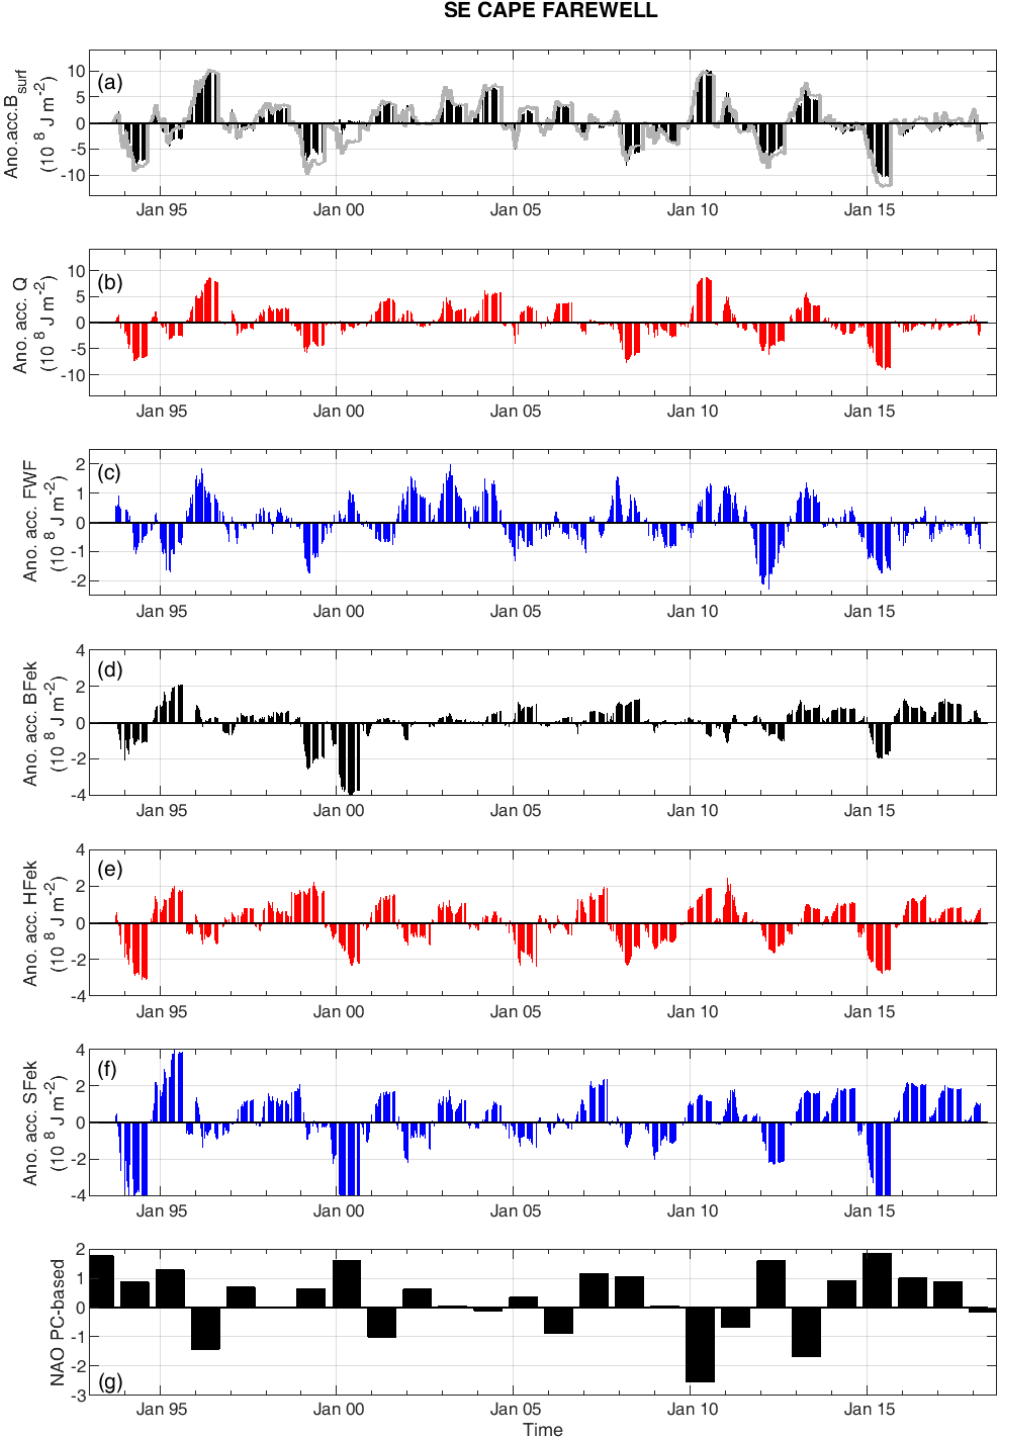
Figure 4. Time series of anomalies of accumulated (a) B ∗ , (b) Q , (c) FWF ∗ (d) BF ek , (e) HF ek and (f) SF ek averaged in the SECF surf region. They are anomalies with respect to 1993–2016. The accumulation was from 1 September to 31 August the following year. The winter North Atlantic Oscillation (NAO) index (Hurrell et al., 2018) is also represented in (g) . The gray line in (a) is the sum of the anomalies of accumulated B ∗ and BF ek . Note that the range of values in the y axis is not the same in all the surf